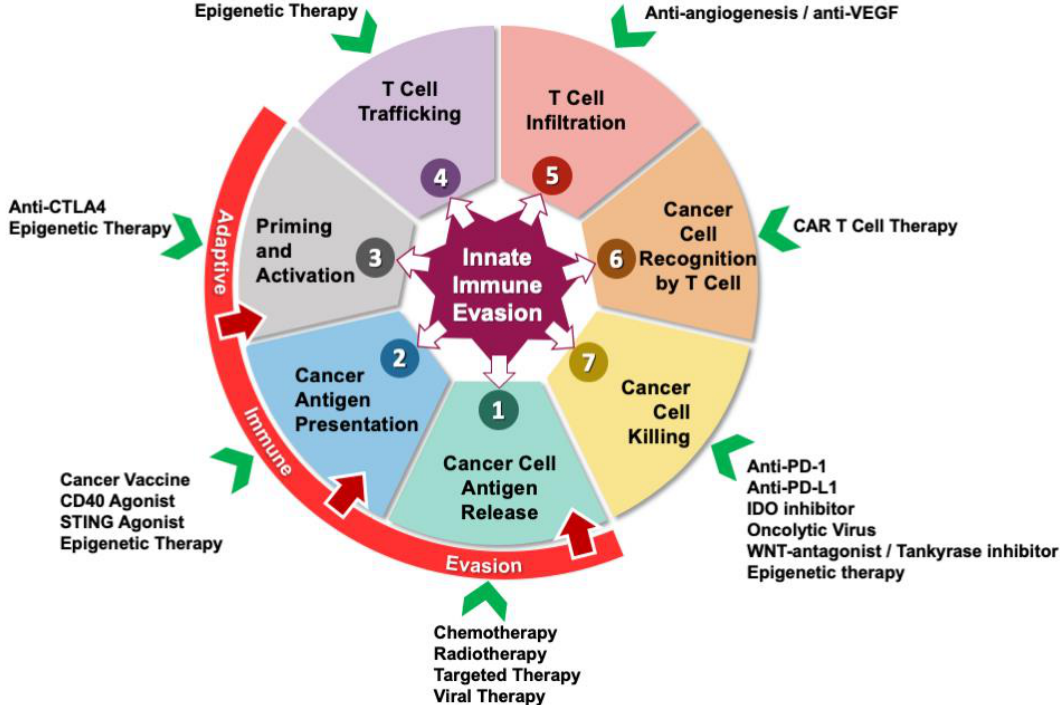
Figure 2. Cancer-immunity cycle can be affected by both innate and adaptive immune evasion mechanisms. Innate immune evasion (dark purple star in the center) is intrinsically driven by pancreatic tumor cells, it can disrupt any steps in the cancer-immunity cycle through various pathways described earlier in Figure 1, whereas the adaptive counterpart (red arc over steps 1 to 3) primarily evades the immunosurveillance of the host via immunoediting and impaired priming of T cells. Conventional therapies such as chemotherapy and radiotherapy (RT), along with newer strategies such as targeted therapy and viral therapy can help in causing cancer cell antigen release (step 1). Cancer antigen presentation (step 2) can be augmented by the use of cancer vaccines, CD40 agonist, stimulator of interferon genes (STING) agonist and epigenetic therapy. Consistent with the effect of epigenetic aberrations on many steps in the cycle, epigenetic treatment can also be employed to target the priming and activation of the T cells (step 3), T-cell trafficking (step 4), and cancer cell killing (step 7). Checkpoint blockade agents including anti-CTLA1, anti-PD-1, and anti-PD-L1 inhibitors can enhance priming/activation and initiate cancer cytolysis, respectively. Targeting anti-angiogenesis via anti-VEGF treatment can help improve T-cell infiltration (step 5) into the tumor microenvironment (TME). CAR T-cell administration is a promising strategy to improve cancer cell recognition by T cells (step 6) in the TME. Numerous strategies besides immune checkpoint blockade therapy can augment cancer cell killing (step 7) by effectors cells within the TME, such as indoleamine 2,3-dioxygenase (IDO) inhibition, oncolytic virus, tankyrase inhibition to antagonize WNT signaling, and epigenetic modulating approaches.